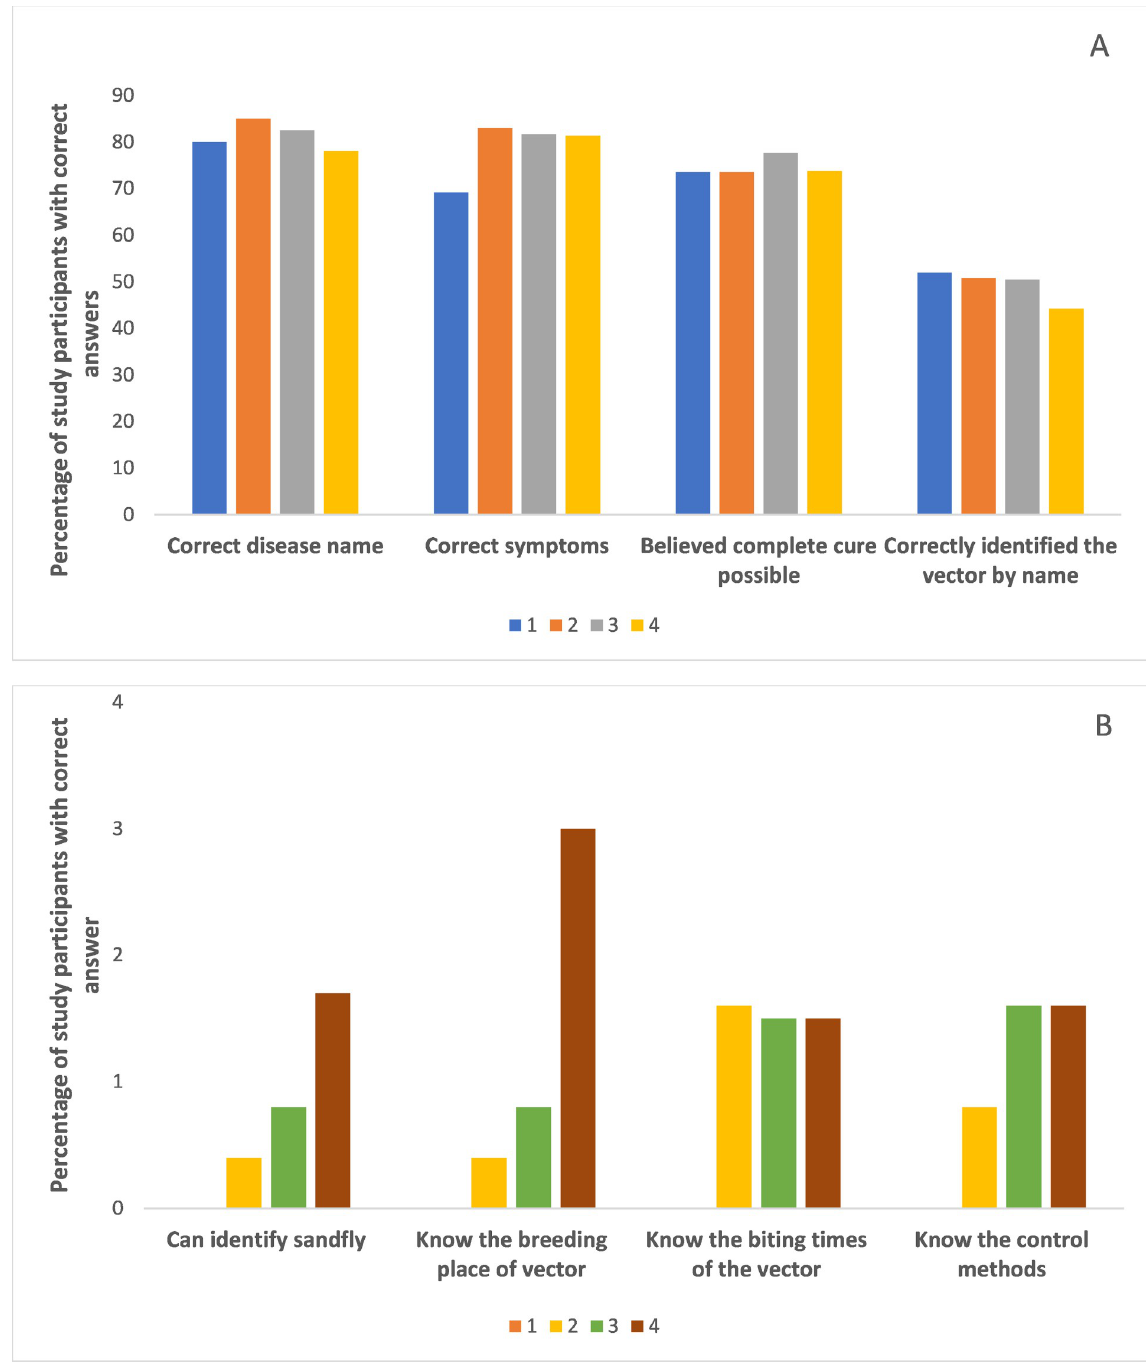
Fig 1. Differences in knowledge according to the education group. The study participants were categorized into four education groups. Fig 1A – Knowledge on disease related facts/Fig 1B – knowledge on vector related facts. Four education levels were compared. 1= No formal education or only primary education: 2= Secondary education: 3=Up to Advanced level education: 4=Degree or